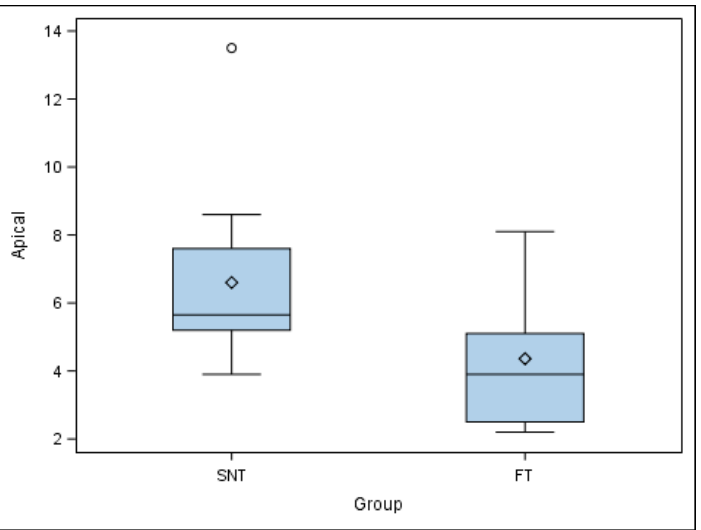
Figure 7. Box plot of the apical deviation of the autotransplanted teeth. The horizontal line in each box represents the respective median value of the study groups. ◊ : Mean value of the box plots. ◦ : Means and extreme value.